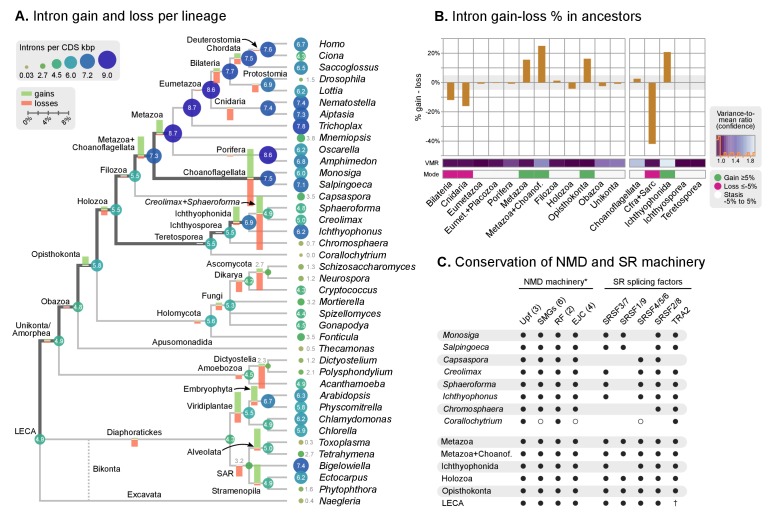
Intron evolution.(A) Rates of intron gain and loss per lineage, including extant genomes and ancestral reconstructed nodes. Diameter and color of circles denote the number of introns per kbp of coding sequence at each ancestral node. Bolder edges mark the lines of descent between the LECA and Metazoa/Ichthyophonida, which were characterized by continued high intron densities (see text). Red and green bars represent the inferred number of intron gains (green) and losses (red) in ancestral nodes. (B) Difference between intron site gains and losses in selected ancestors, including animals (left; from Metazoa to Unikonta/Amorphea) and unicellular holozoans (right). For each ancestor, we specify the variance-to-mean ratio of the inferred number of introns from 100 bootstrap replicates (higher values, denoted by lighter purple, indicate less reliable inferences; see Methods. The color code denotes modes of intron evolution: dominance of gains (green), losses (pink) and stasis (light gray). (C) Conservation of the NMD machinery and SR splicing factors in unicellular holozoans (up) and selected ancestors (down). Black dots indicate the presence of an ortholog, and empty dots partial conservation. For the NMD machinery, each column summarizes the presence of multiple gene families (number between brackets). † denotes the ancestral eukaryotic origin of TRA2 according to (Plass et al., 2008). Complete survey at the species and gene levels available as Figure 4—figure supplements 2 and 3. Figure 5—source data 1, 2 and 3.DOI:
http://dx.doi.org/10.7554/eLife.26036.01810.7554/eLife.26036.019Figure 5—source data 1.Rates of gain and loss of intron sites for extant and ancestral eukaryotes, calculated for a rates-across-sites Markov model for intron evolution with branch-specific gain and loss rates (Csurös, 2008).Used in Figure 5.DOI:
http://dx.doi.org/10.7554/eLife.26036.01910.7554/eLife.26036.020Figure 5—source data 2.Reconstruction of intron site evolutionary histories, using a rates-across-sites Markov model for intron evolution, with branch-specific gain and loss rates (Csurös, 2008).Used in Figures 5 and 6.DOI:
http://dx.doi.org/10.7554/eLife.26036.02010.7554/eLife.26036.021Figure 5—source data 3.Reconstruction of the evolution of the NMD machinery (He and Jacobson, 2015) and key SR splicing factors (Plass et al., 2008).Used in Figure 5.